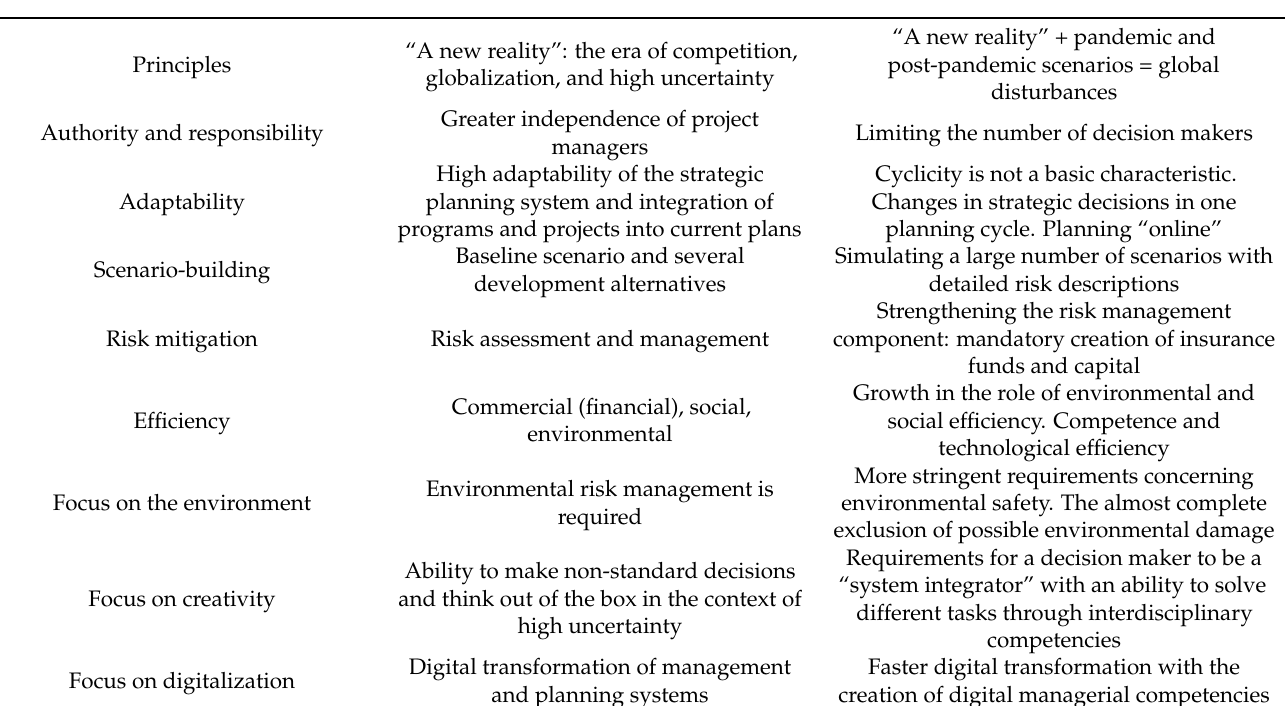
Table 2. Changes in the principles of the strategic management and planning of oil and gas companies in the context of global